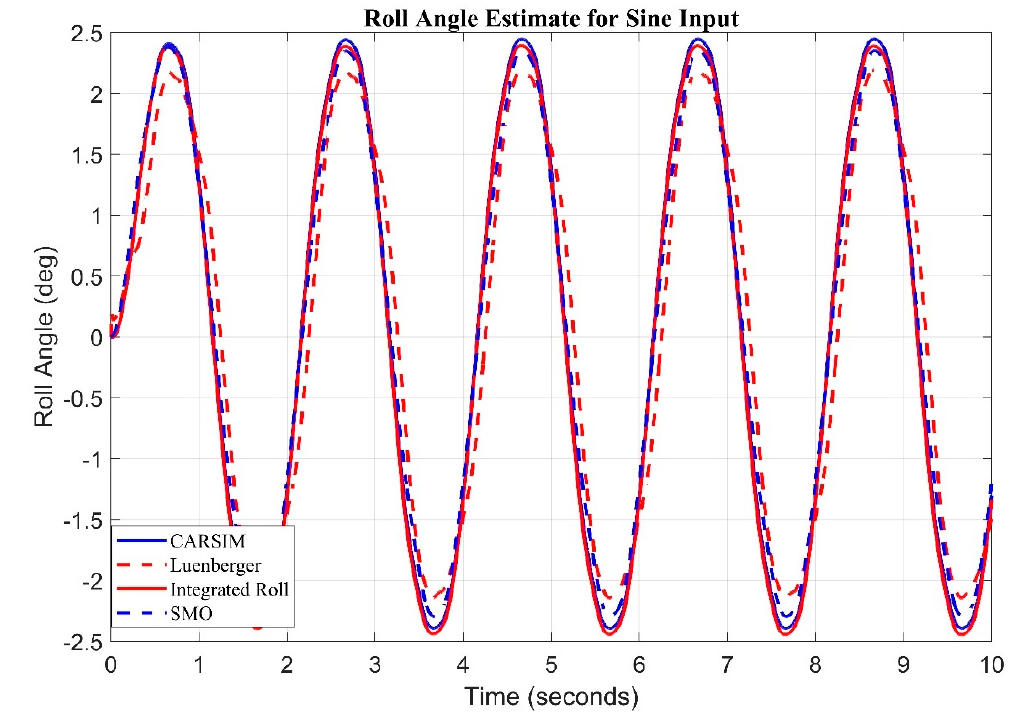
Figure 12. Observer Results for sine input estimate of Roll Angle .